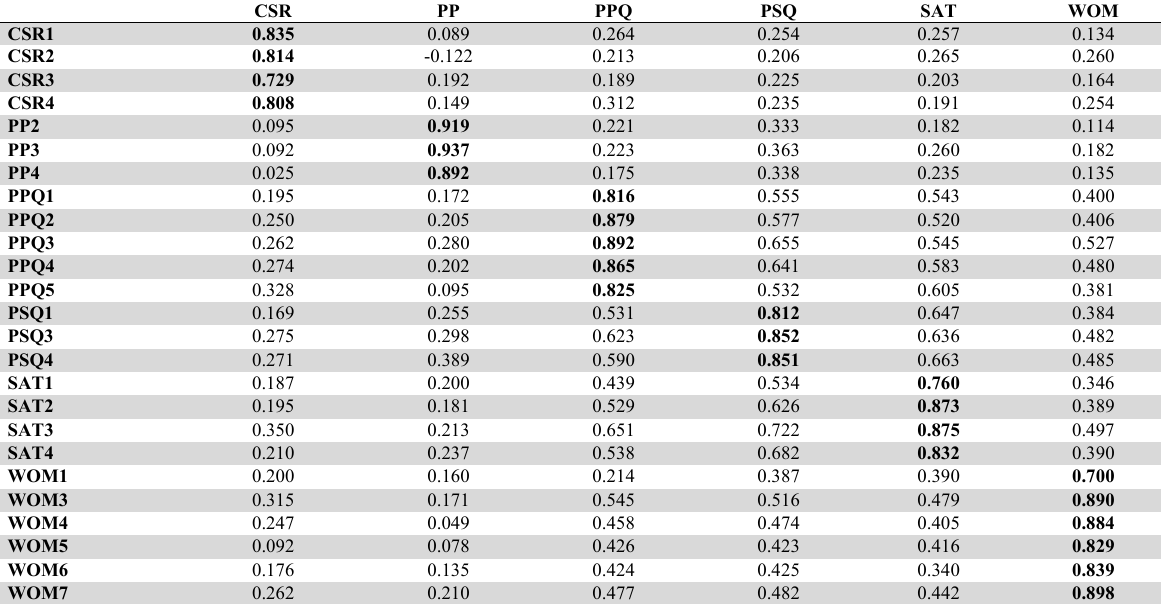
Table 4 Cross-loadings